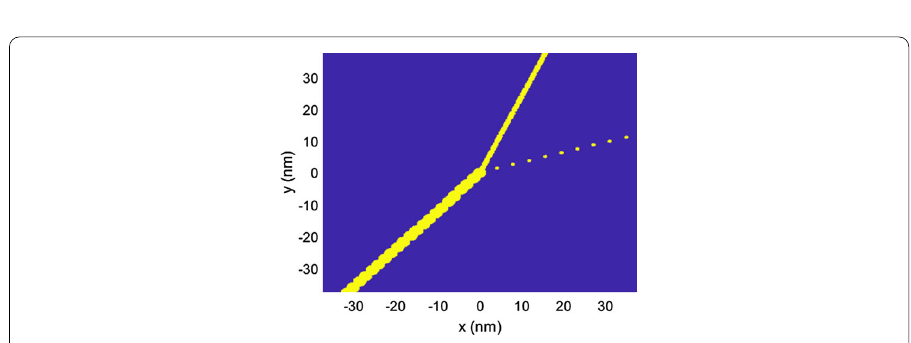
Fig. 8 Point defects sink regions (shown in yellow) for the triple junction with angles 25 ◦ , 75 ◦ , and − 10 ◦